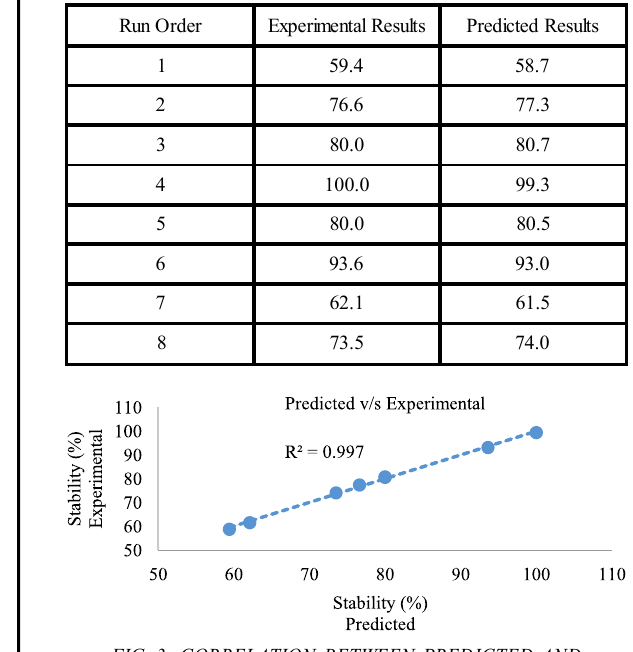
FIG. 3. CORRELATION BETWEEN PREDICTED AND EXPERIMENTAL TABLE 3. COEFFICIENTS AND P-VALUES OF PARAMETERS